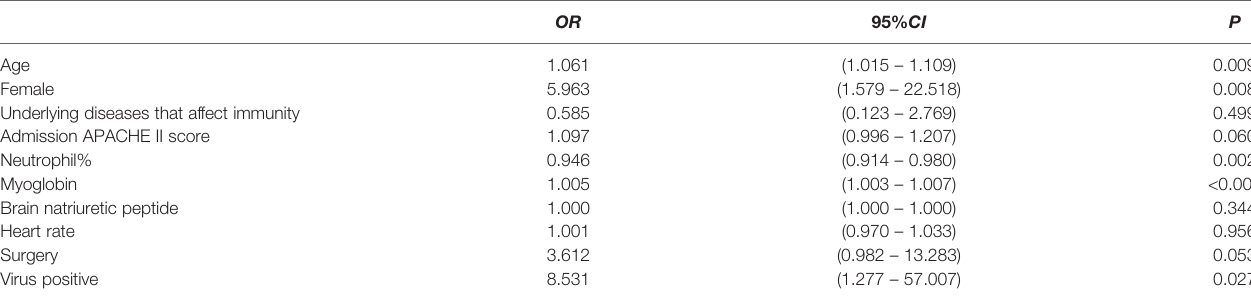
TABLE 6 | Risk factors for